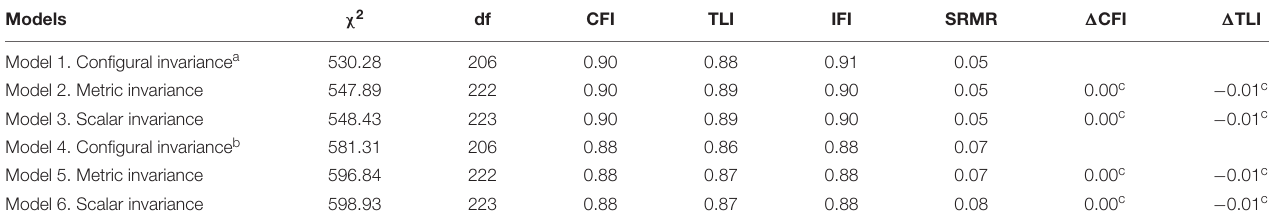
TABLE 3 | Results of the measurement invariance testing across gender and age. Models χ 2 df CFI TLI IFI